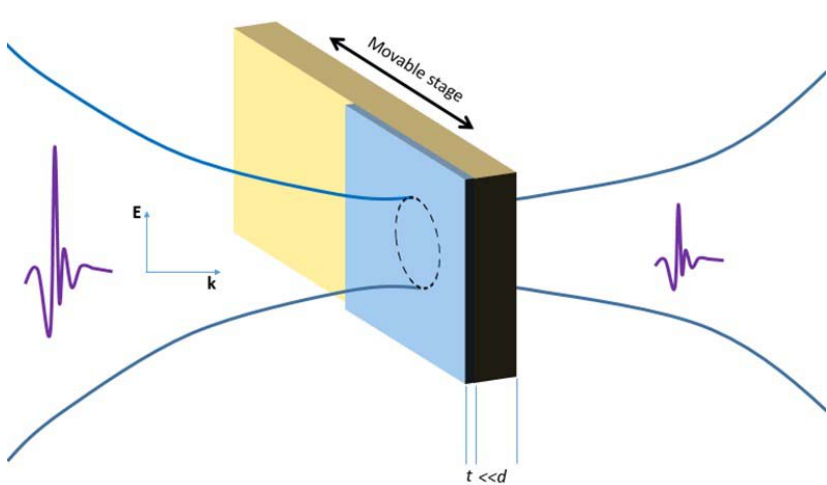
Figure 1. Sketch of the experimental setup. The blue area represents the film deposited on half the SiO 2 substrate (depicted in yellow). A step motor controlled the position of the sample with respect to the impinging THz pulse.